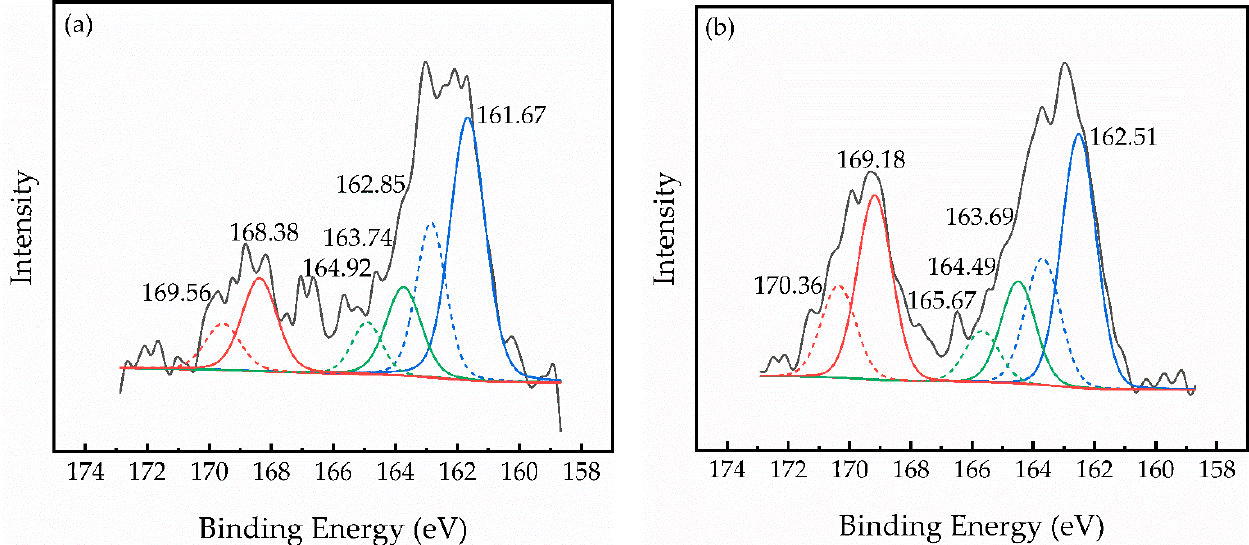
Figure 7. O1s XPS spectra of malachite surfaces as follows: ( a ) treated with Na 2 S, ( b ) treated with